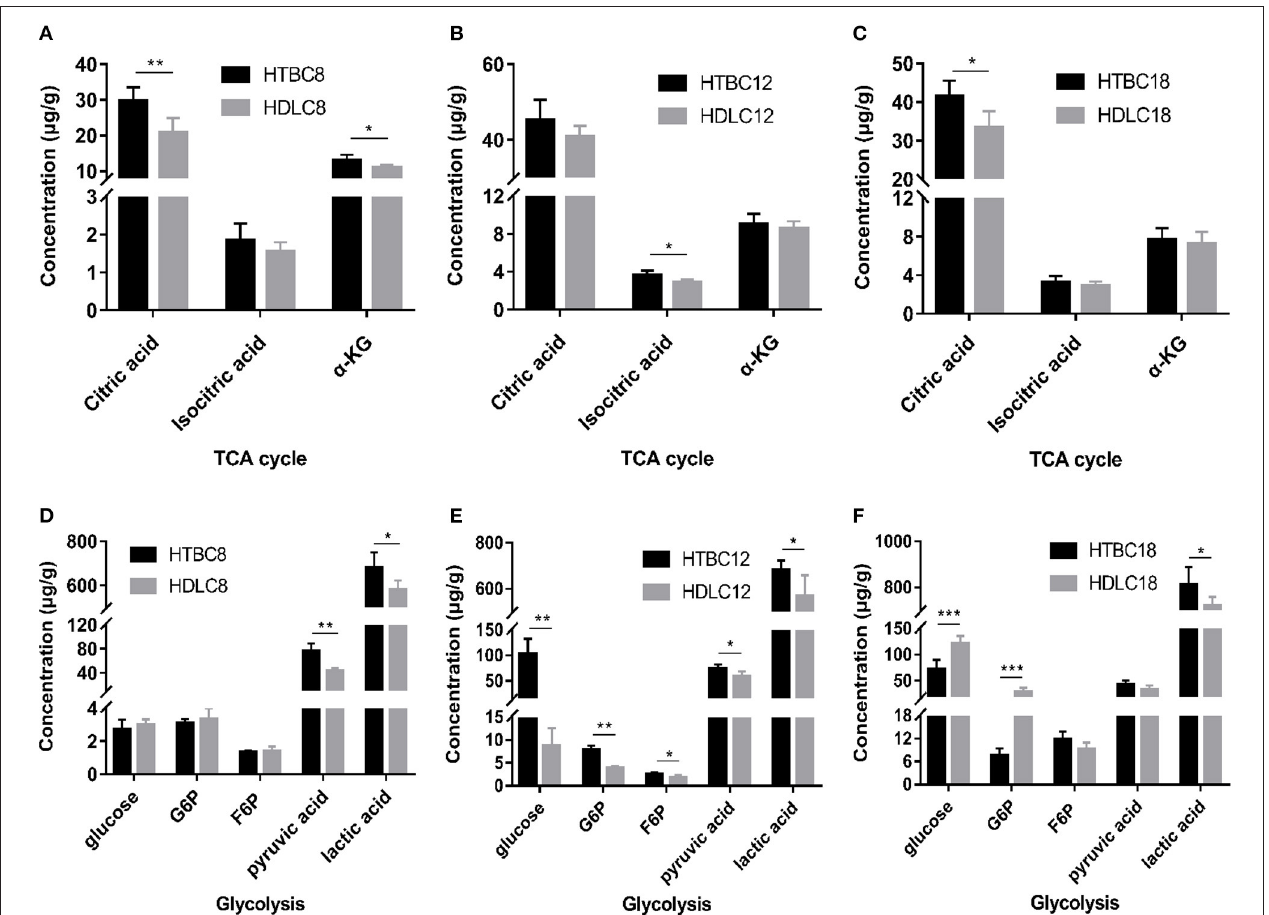
FIGURE 5 | The metabolome results under hypoxia at different developmental stages of chicken. (A–C) The concentration of intermediate metabolites in the TCA cycle on days 8, 12, and 18 of incubation under hypoxia ( n = 6–8). (D–F) The concentration of intermediate metabolites during glycolysis on days 8, 12, and 18 of incubation under hypoxia ( n = 6–8). HTBC, TBCs under hypoxia; HDLC, TBCs under hypoxia. Data are indicated as the mean ± SEM. Asterisks represent significance TBCs compared to DLCs. * P < 0.05, ** P < 0.01, *** P < 0.001.